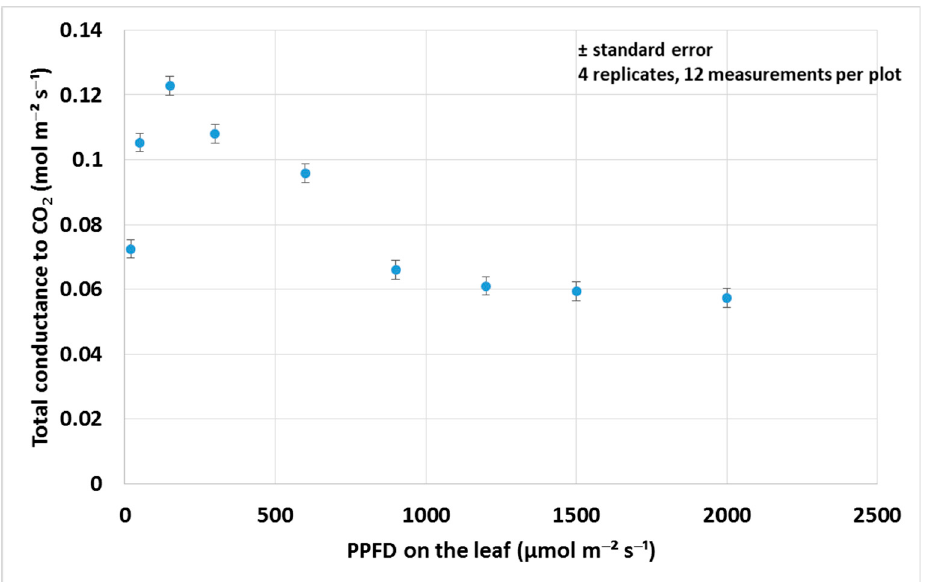
Figure 6. Total conductance to CO 2 light curve in winter barley, average of cultivars, 26 May (BBCH 73–75), N 90 P 45 K 50 (Debrecen, 2020) 4 replicates, 12 measurements (2 leaves, 6 recordings per leaf). Higher PPFD levels caused stress and decreased significantly the total conductance to CO 2 . The